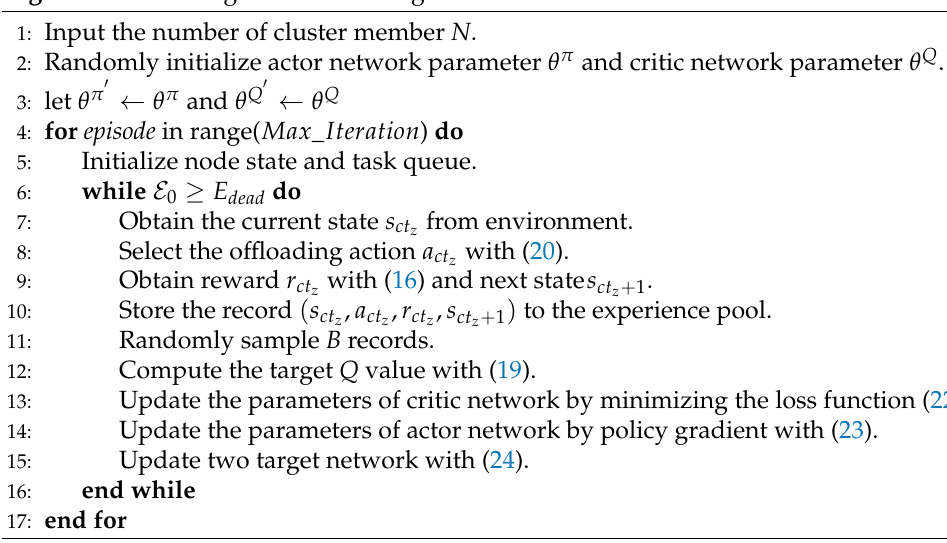
Figure 4. The training of the DDPG algorithm. Algorithm 2 Training of the DDPG